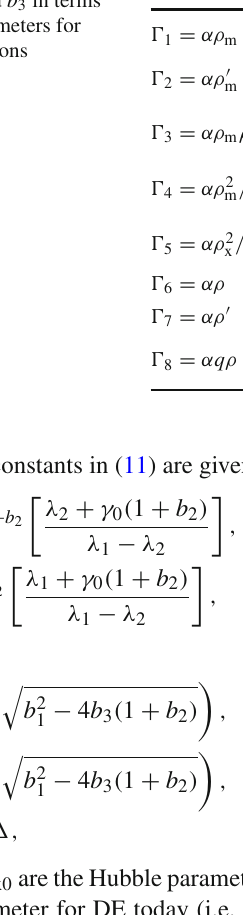
Table 1 Definition of the constants b 1 , b 2 and b 3 in terms of the relevant parameters for the studied interactions